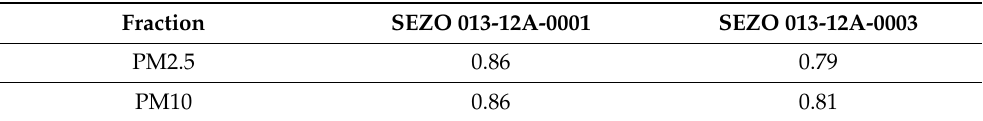
Table 3. Determination coefficient (R 2 ) for each of the SEZO sensors against the reference analysers in the dust chamber.